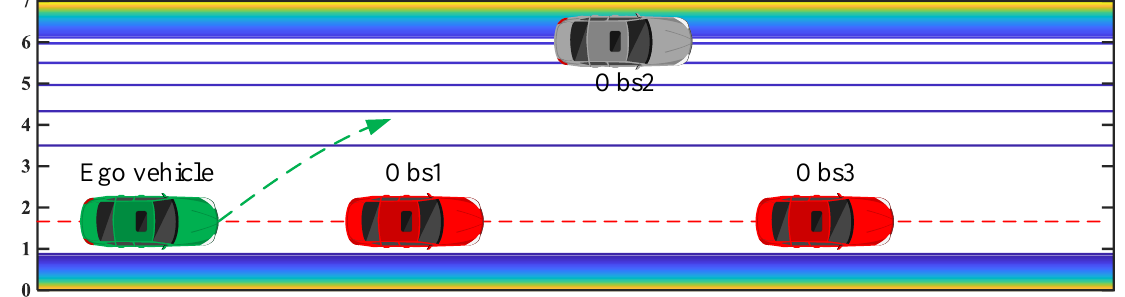
Figure 12. A static driving scenario with three vehicles parked on